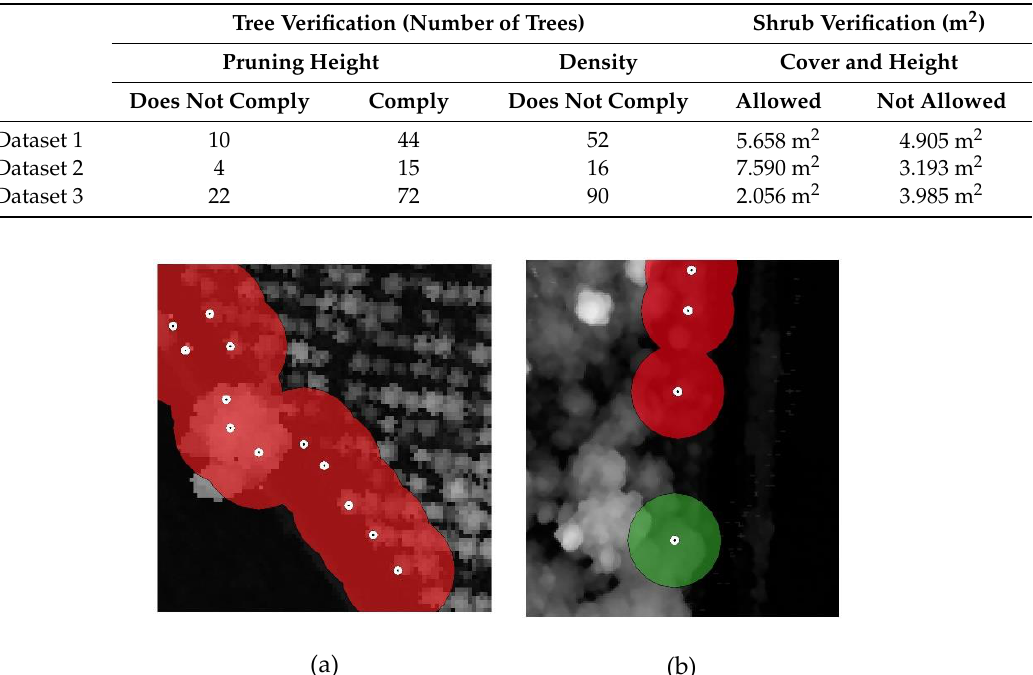
Pruning height and density criteria were verified for trees and cover, and height criteria were verified